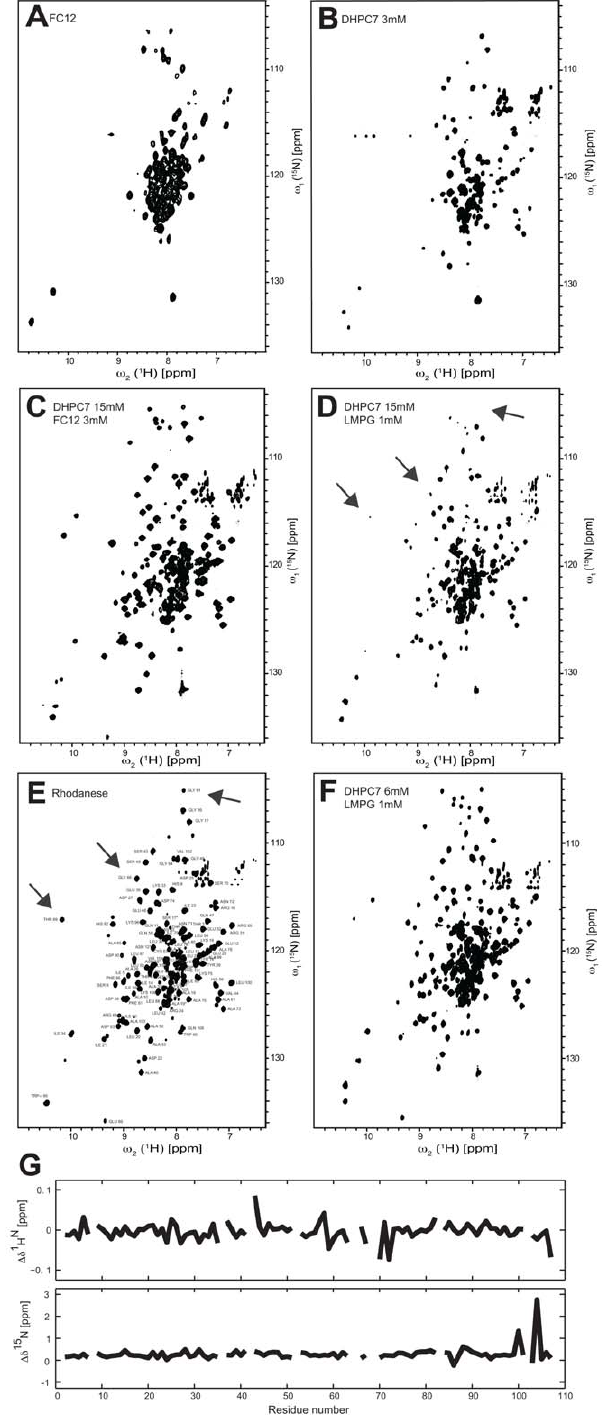
Figure 1. NMR spectra of YgaP in various micellar systems as indicated. 2D [ 15 N, 1 H]-TROSY spectra of 2 H, 15 N-labeled YgaP 2 in ( A ) FC12, ( B ) DHPC-7, ( C ) DHPC-7 and FC12, ( D, F ) DHPC-7 and LMPG. ( E ) 2D [ 15 N, 1 H]-TROSY of the N-terminal rhodanese domain of YgaP. The individual cross peaks are labeled according to the sequential assignment. ( G ) 1 H and 15 N chemical shift differences (labeled Dd 1 H N and Dd 15 N) between the N-terminal rhodanese domain in solution and the N-terminal rhodanese domain of full length YgaP 2 in the optimized mixed micellar conditions (i.e. 6 mM DHPC, 1 mM LMPG). The lack of profound up- or down-filed D d 1 H N and D d 15 N chemical shift